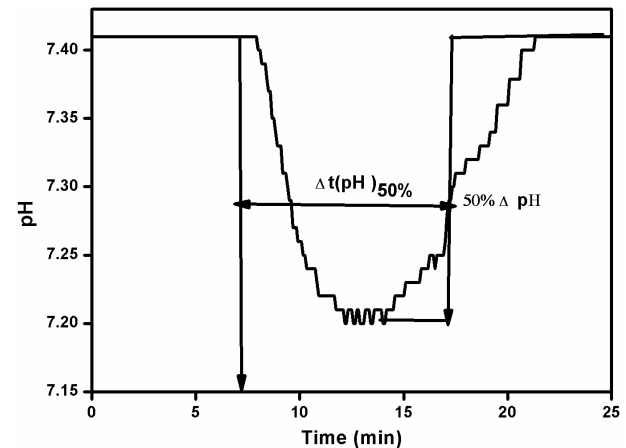
Figure 6. Determination of ∆t(pH) 50% from the pH profile for the Q fibrous packed column. Conditions: Buffer A, 500 mM phosphate, pH 7.4; Buffer B, 20 mM phosphate, pH 7.4.; column (5 mm ID × 5.5 cm L). Method: 100% Buffer A (8 min) step to 100% Buffer B (24 min). Flow rate: 150 cm/h. Detection: